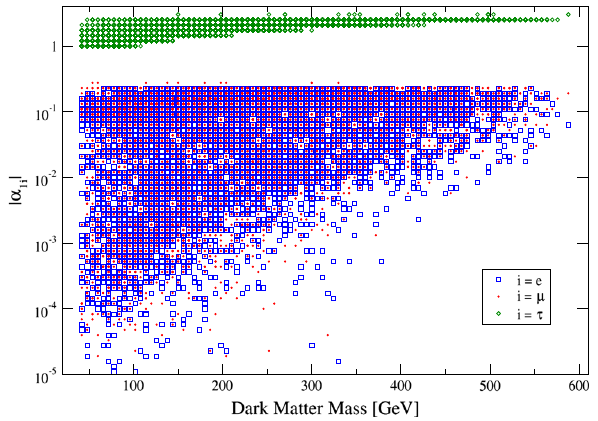
Fig. 3 The viable models projected onto the plane ( m φ , α i 1 ). The α i 1 couplingsdeterminethedarkmatterannihilationrateandmusttherefore be